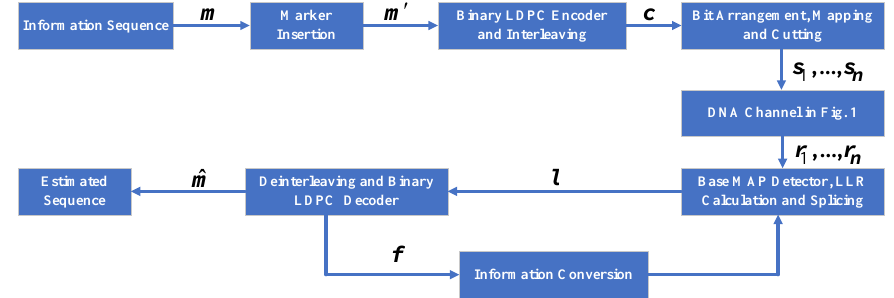
Figure 3. The procedure of the improved marker code scheme.